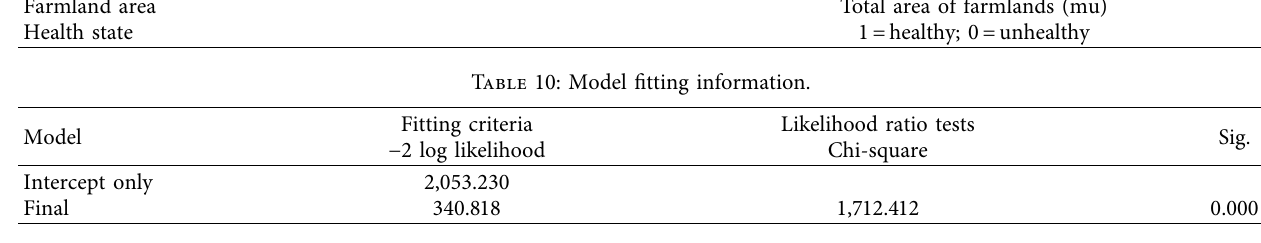
Table 11: Pseudo R -squared.